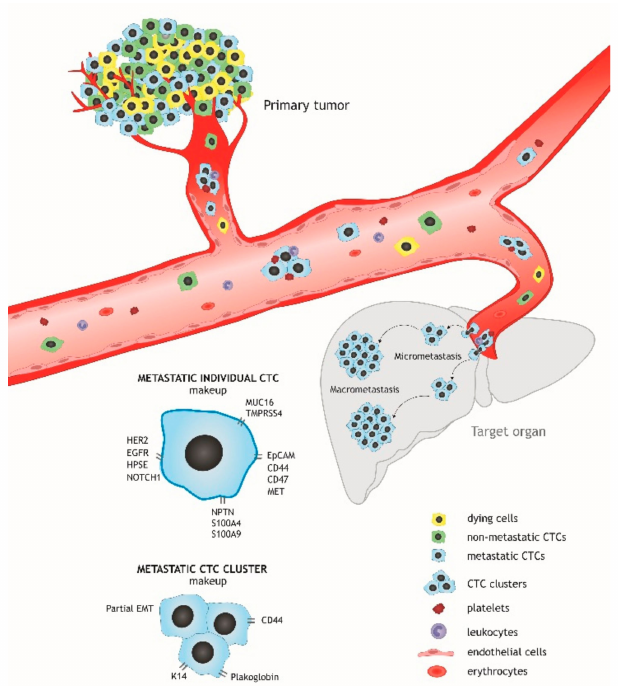
Figure 1. Metastatic circulating tumor cells (CTCs). Most tumor cells entering the circulation die and only part of them survives and is able to extravasate and form micro- and macrometastases. Such cells can be both individual and clustered. Their increased surviving and metastasis-initiating ability is probably related to the expression of specific molecules involved mainly in EMT and stemness